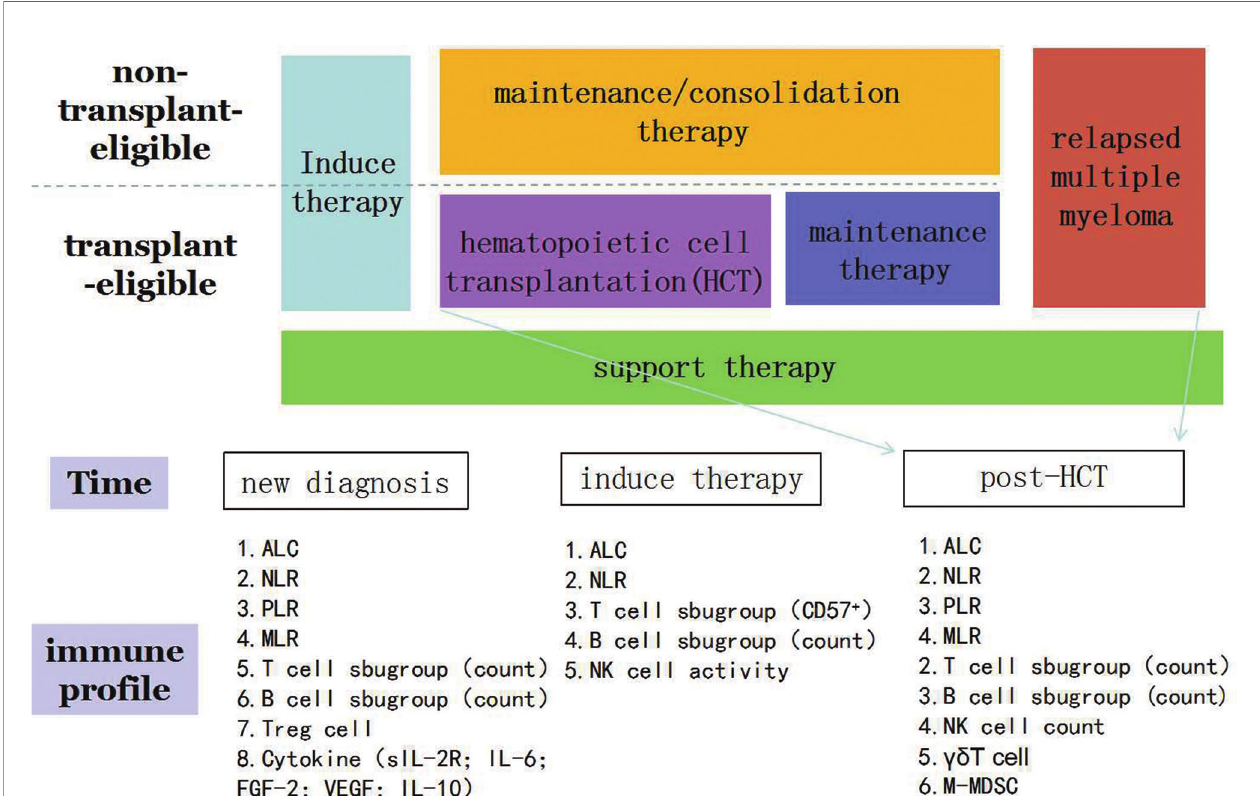
FIGURE 1 | Immune pro fi ling in the prediction of survival of patients with multiple myeloma. ALC, absolute lymphocyte count; NLR, neutrophil-to-lymphocyte ratio; PLR, platelet-to-lymphocyte ratio; MLR, monocyte-to-lymphocyte